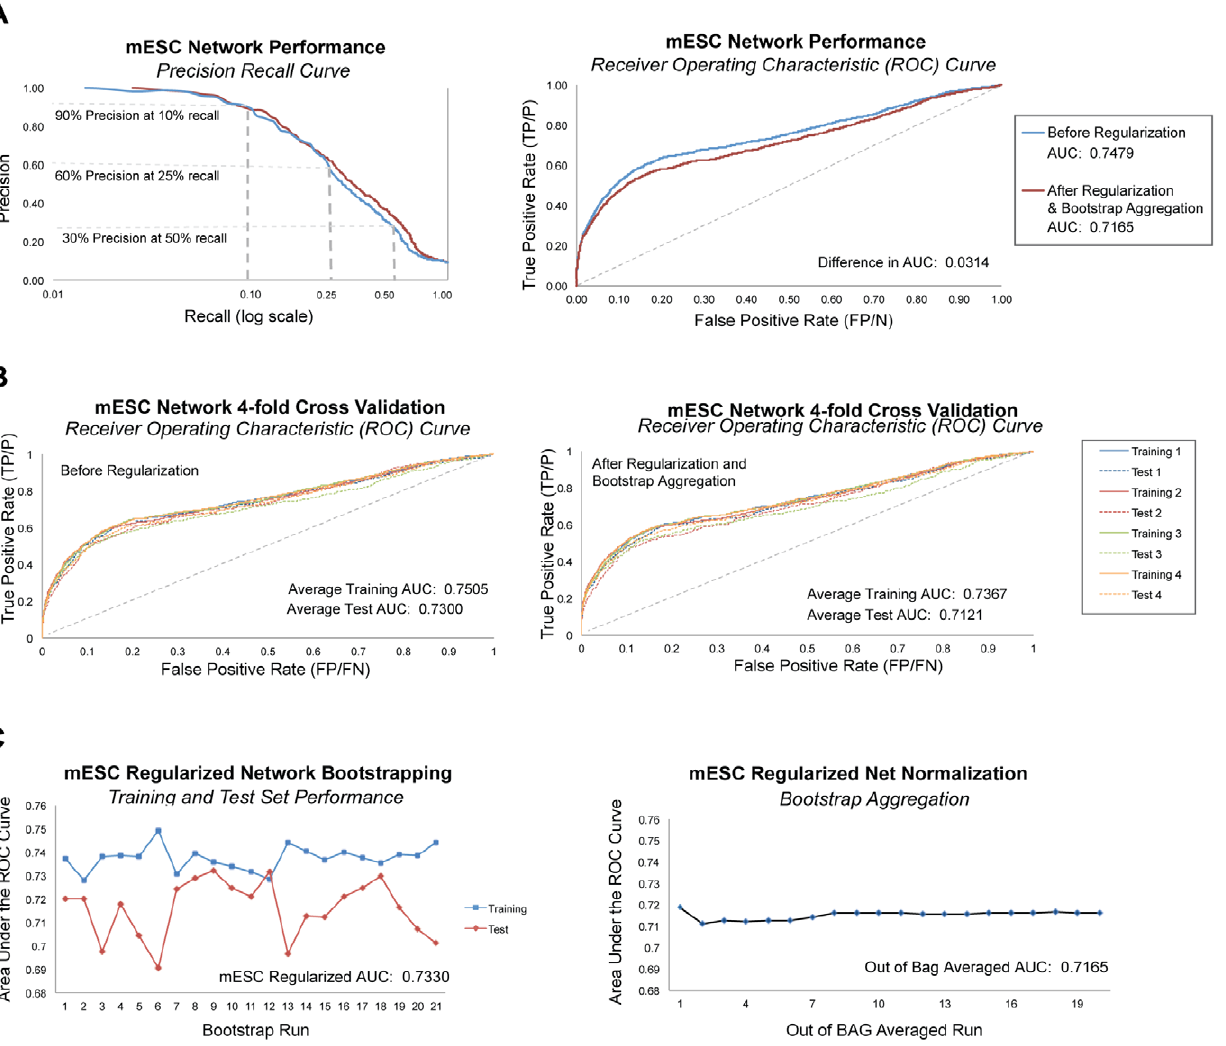
Figure 3. Network Performance Evaluations. A. Computational assessment of network performance using standard machine learning metrics showed that precision at 10% recall was 90%, and 60% at 25% recall, before and after regularization and out of bag averaging to correct for overfitting to noise. The area under the Receiver Operating Characteristic (ROC) curve (AUC) for the mESC network was 0.7479; after regularization and out of bag averaging, the AUC was 0.7165. B. We conducted 4-fold network cross validations by removing 25% of edges in the gold standard (4- fold Gold Standard). ROC curves showed a small amount of overfitting, most apparent in cross validations for which we removed 25% of genes (rather than edges) from the network training set (Figure S1). C. We conducted 20 bootstrap runs, using 70–30 split (training to test) of the gold standard answer file, and performed out-of-bag averaging to produce a single network. The relatively flat trend of AUC over out-of-bag-averaging runs confirms the minimal amount of overfitting and produced a single network with high confidence inference scores.